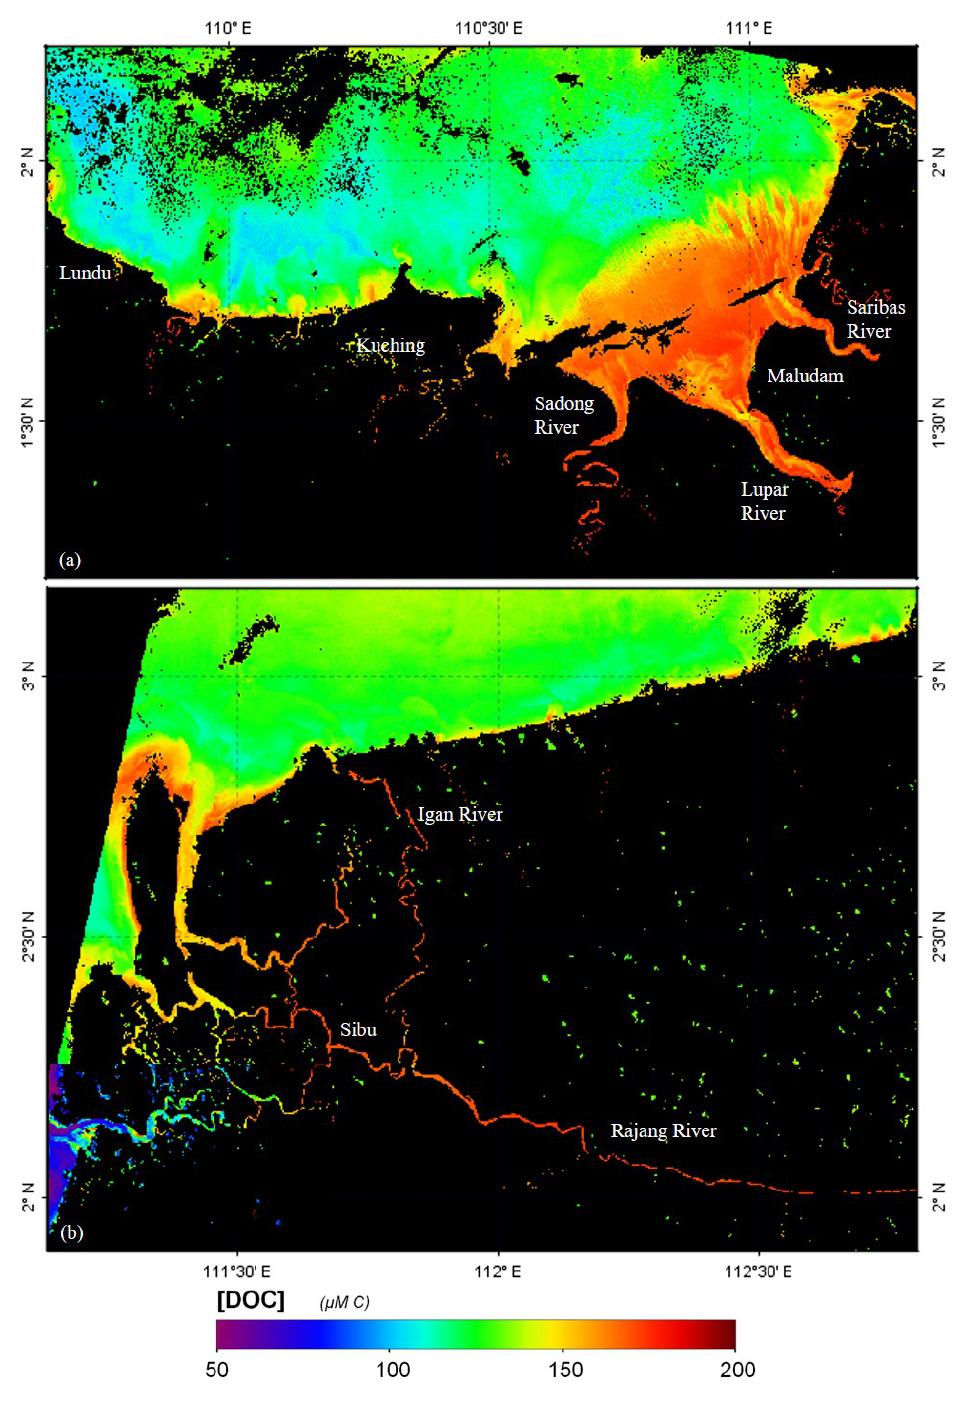
Figure 4. Processed Landsat-8 images from 22nd November 2013 and 27th August 2013, showing DOC concentrations for the Sadong and Lundu basins ( a ) and part of Rajang basin ( b ). Black pixels represent land or cloud